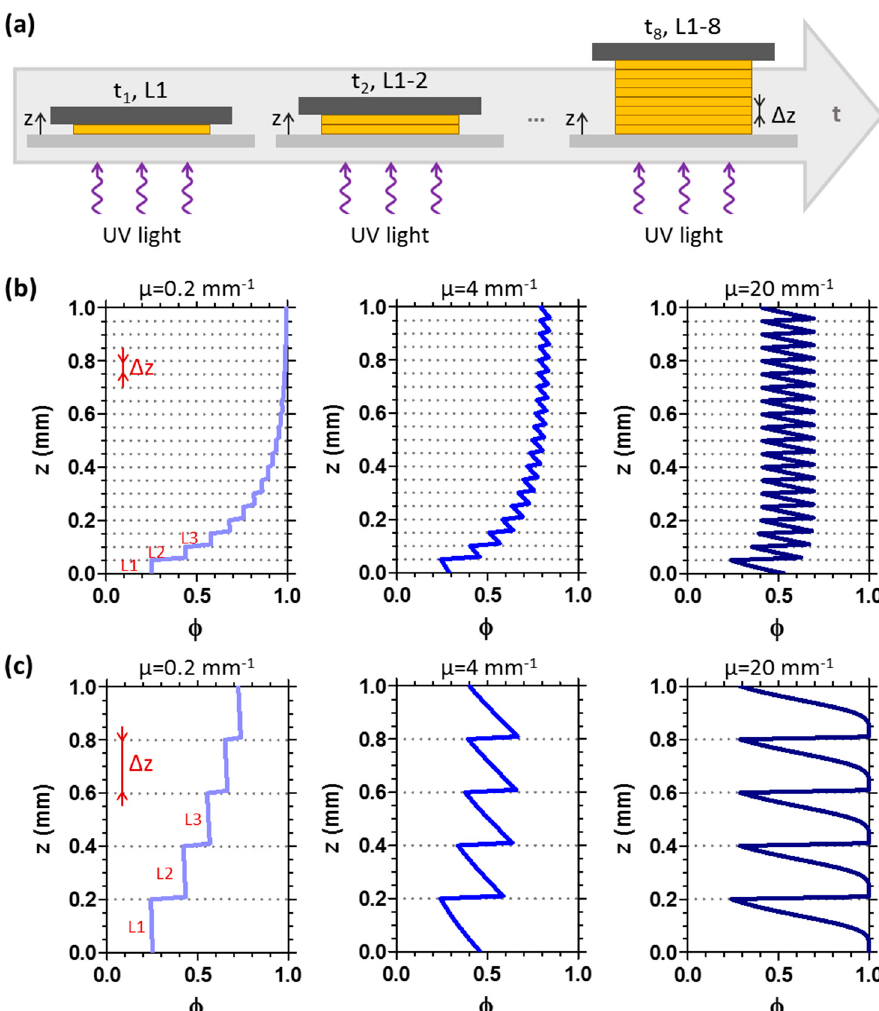
Figure 6. ( a ) Schematic of the step sequence during UV-3D printing. Each layer forming the printed object has a thickness corresponding to Δ z . In ( b , c ), different conversion φ profiles along the sample depth z for 3D printed objects are reported. The layer thickness during the printing process ( Δ z ) is set as 50 μ m ( b ) and 200 μ m ( c ). Profiles are modelled imposing μ = 0.2 mm − 1 , μ = 4 mm − 1 and μ = 20 mm − 1 .